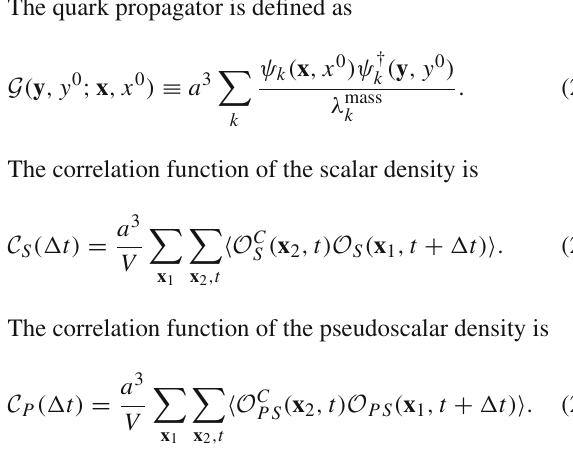
(cid:5)¯ λ | Q | (cid:6) k with the prediction of the chRMT. The normal configurations and configurations of the magnetic (cid:5)¯ λ | Q | (cid:6) j